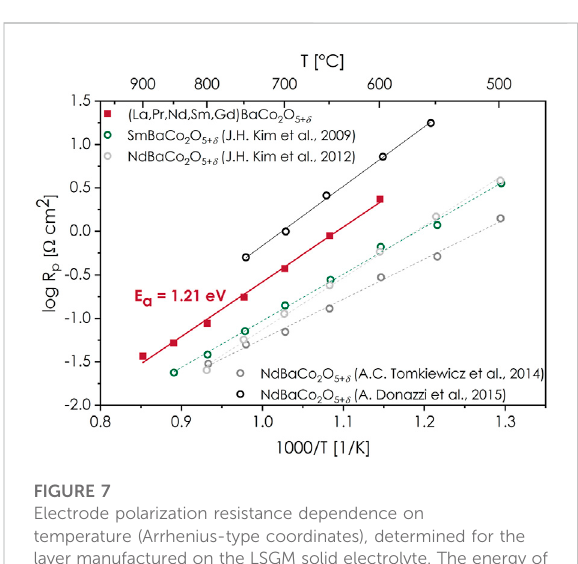
FIGURE 7 Electrode polarization resistance dependence on temperature (Arrhenius-type coordinates), determined for the layer manufactured on the LSGM solid electrolyte. The energy of activation is calculated according to Arrhenius relation: R p = R p,0 exp( E a / kT ). The literature data for NdBaCo 2 O 5+ δ and SmBaCo 2 O 5+ δ are also provided (Kim et al., 2009; Kim and Irvine, 2012; Tomkiewicz et al., 2014; Donazzi et al., 2015).